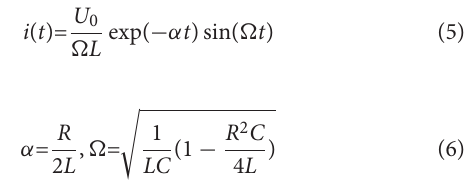
electric field with the current flowing through each single